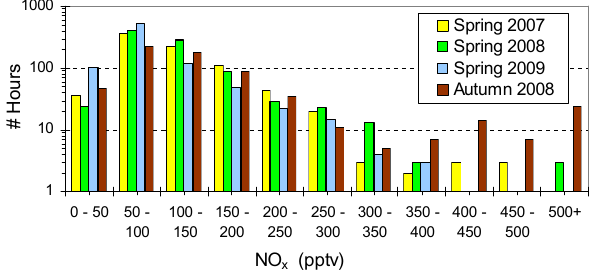
Figure 2. Distribution of hourly median NO x datapoints for the four seasons of interest. Notice the different distribution for autumn 2008 where the data is skewed towards much larger NO x values. Also note the y-axis is logarithmic.